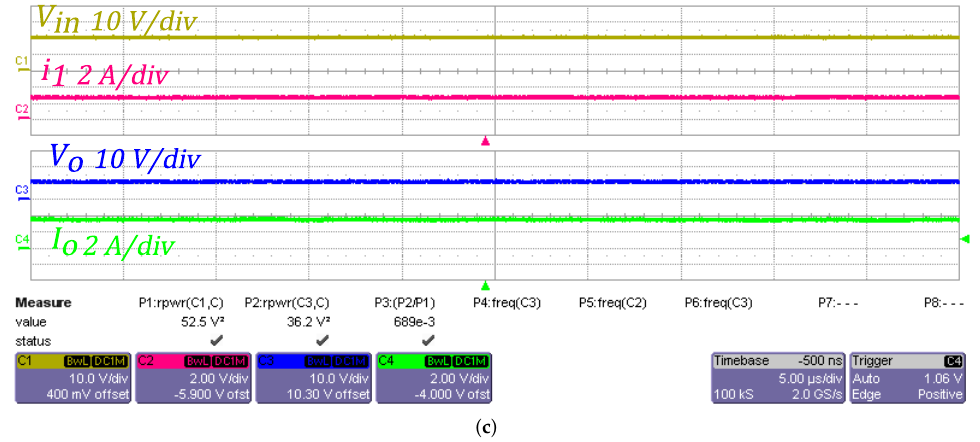
Figure 10. Experimental waveforms of the qZS-IPT system in buck mode with D = − 0.2. ( a ) Input voltage V in and current i 1 , DC − link voltage v dc and current i dc . ( b ) primary side voltage v p and current i p , secondary side voltage v s and current i s . ( c ) input voltage V in and current i 1 , output voltage V o and current I o .